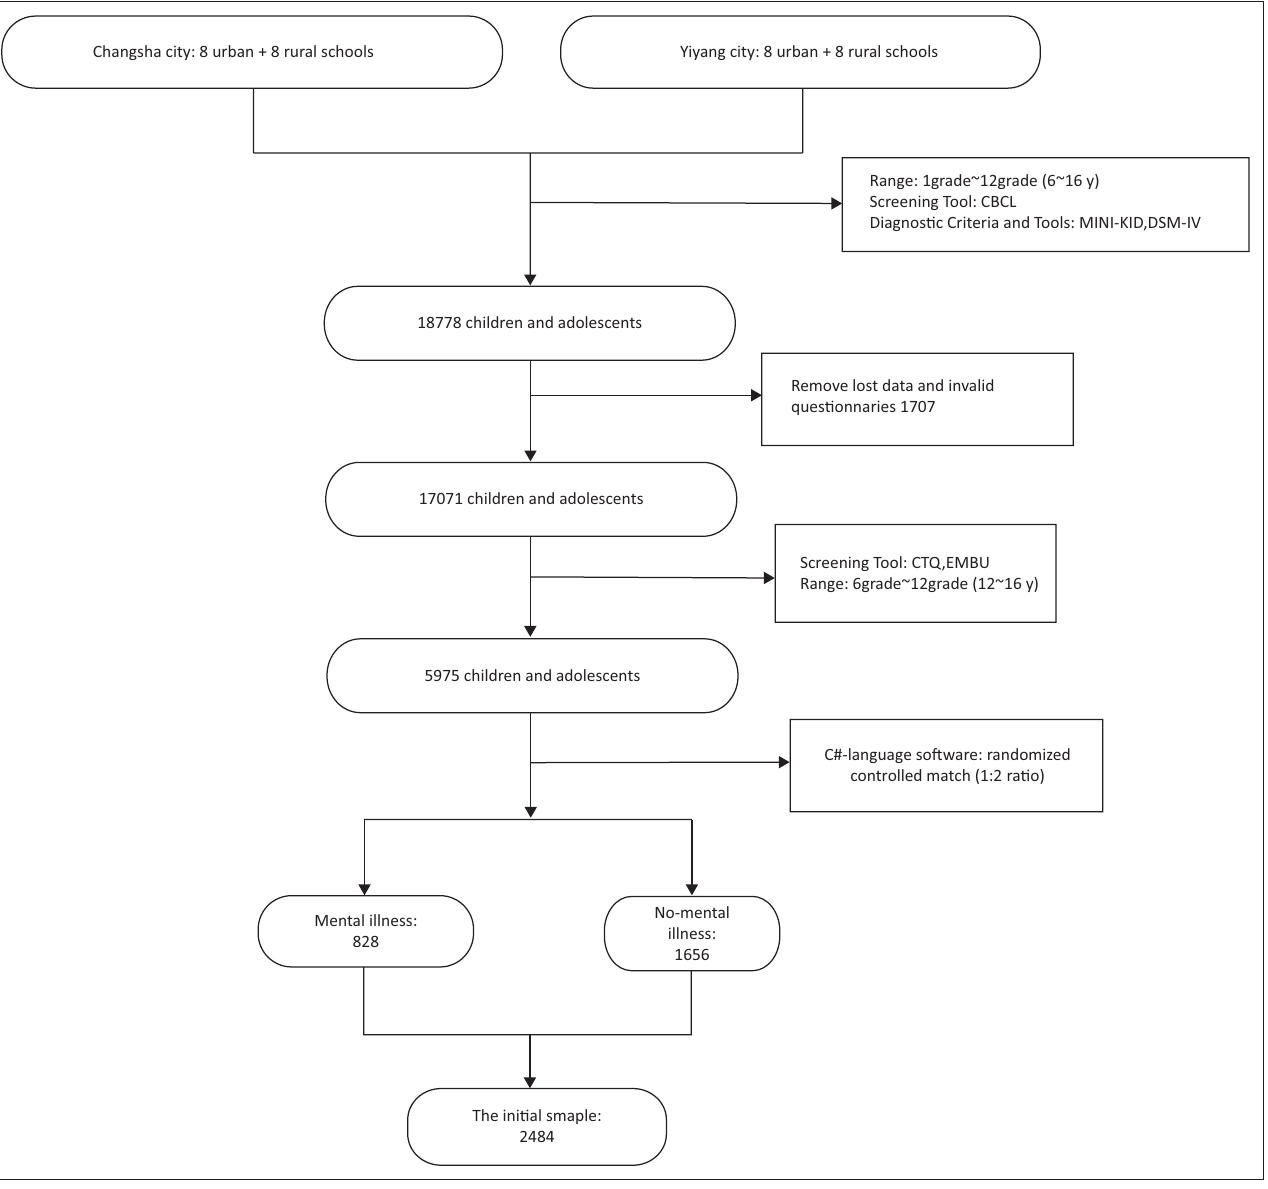
FIGURE 1: The flowchart of detailed investigative